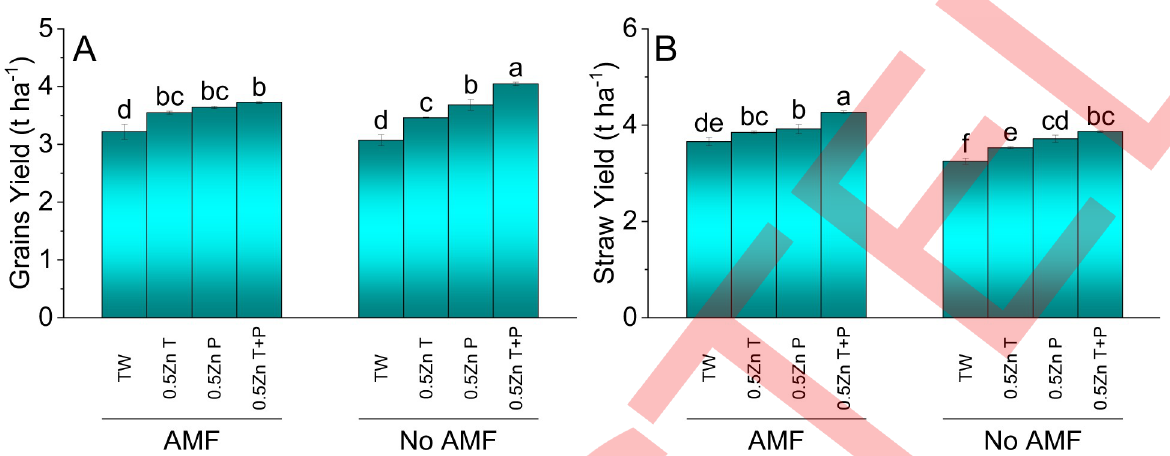
Fig 4. Effect of zinc foliar application at tillering and panicle stages with and without AMF inoculation on rice grains yield (A) and straw yield (B). Bars are means of three replicates ± SE. Variable letters on bars indicate significant difference at p � 0.05 according to LSD test. TW = tap water (control); T = tillering stage; P = panicle stage; Zn = zinc.